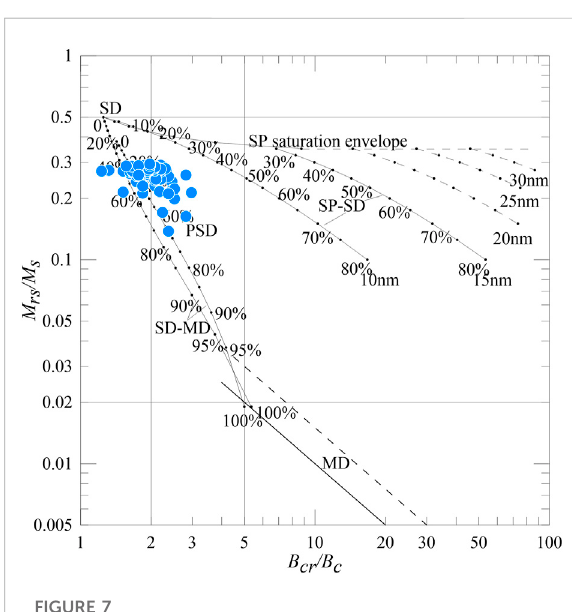
FIGURE 7 Day plot of hysteresis ratios for the samples of core H10. SD, single-domain; PSD, pseudo-single-domain; MD, multi-domain; SP, superparamagnetic (modi fi ed from Day et al., 1977; Dunlop,